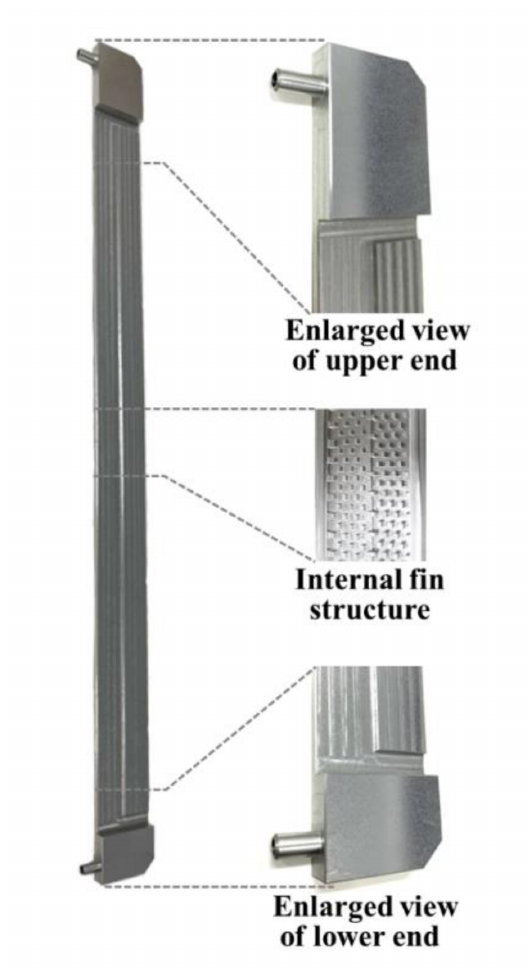
Figure 12. Hardware of the cold plate. The main function of the shunt is to make the mass flow rate of the coolant flowing into each cold plate the same. Since there are four fluid cold plates in this system, a one-in and four-out shunt was designed for the flow control in this study. The hardware of the shunt is shown in Figure 13.